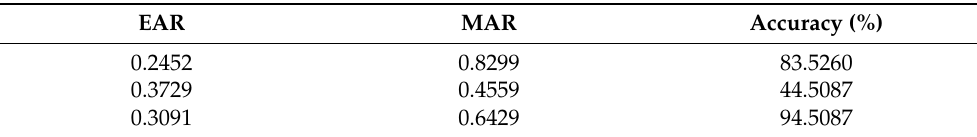
Table 5. Comparison with different statistical thresholds on the HNUFDD dataset for fatigue driving behavior